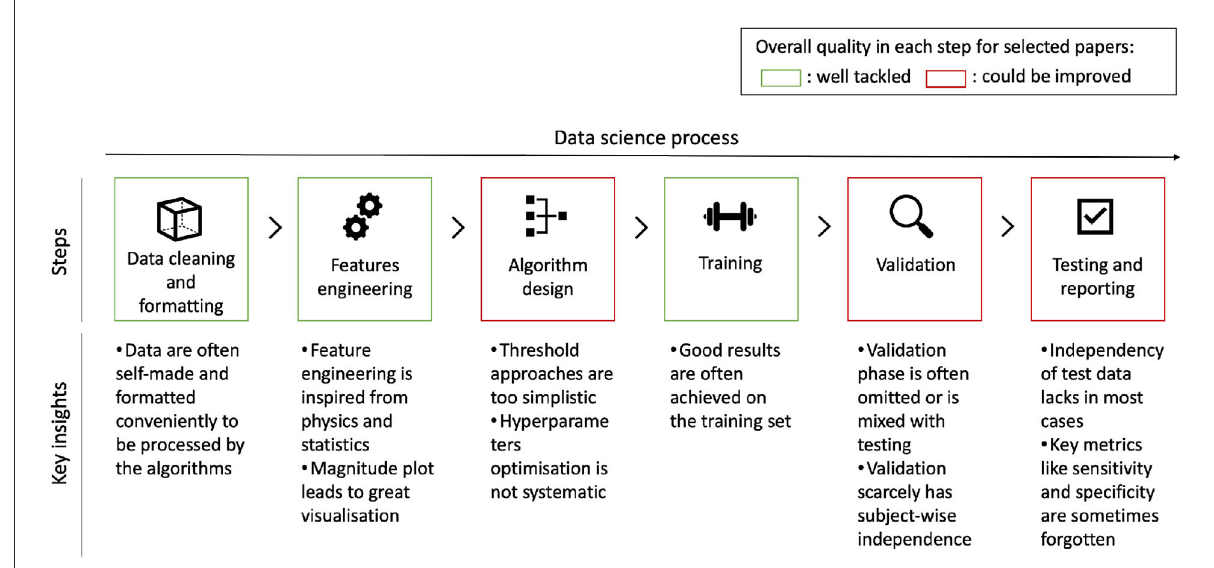
FIGURE10 Data science process and overall quality analysis for each step for the included papers. Algorithm design, validation, and testing are notable areas for improvement.